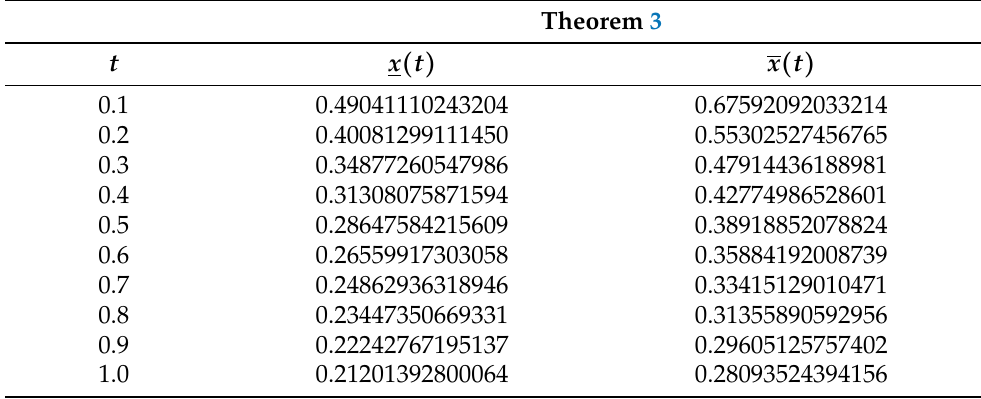
Table 3. Solution enclosures according to Theorem 3 for the uncertain fractional derivative order ν ∈ [ 0.5 ; 0.6 ] in the example (37) with